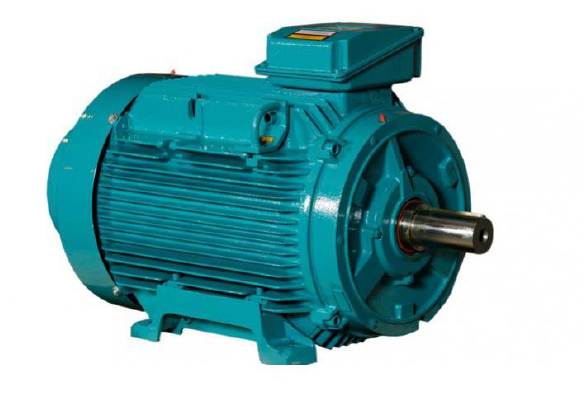
Fig. 3. View of the 4Sg200L-4-IE2 motor